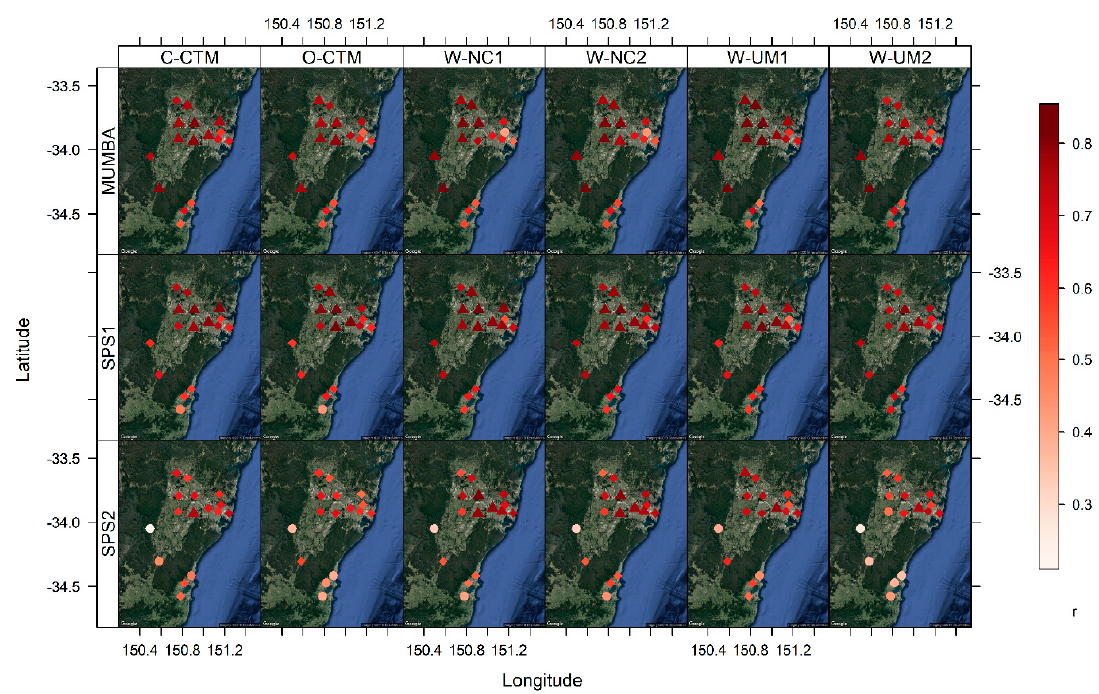
Figure 5. Map showing correlation performance between each model and the observed hourly O 3 values at the 16 DPIE air quality monitoring stations during the MUMBA, SPS1 and SPS2 campaigns. Sites at which the goal is met (r > 0.75) are shown as triangles. Sites at which the goal is not met, but the correlation criteria (r > 0.5) is exceeded are shown as diamonds.